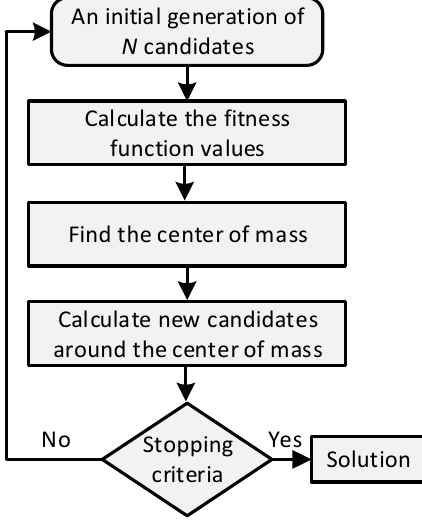
Figure 2. BB–BC optimization algorithm flow chart.